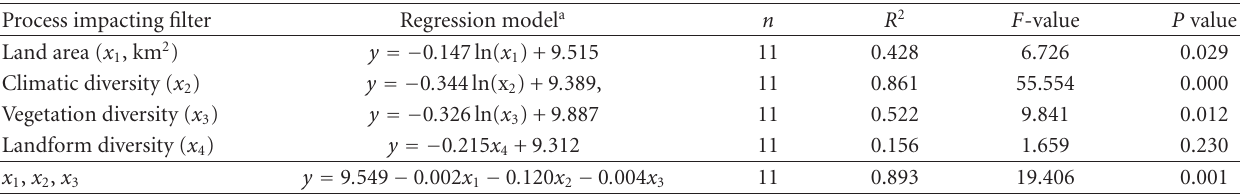
Table 4: The respective regression of species pool e ff ect, ln Y , from Yunnan flora region pool to flora subregion pools, on land area, climate, vegetation, and landform diversity in these subregion species pools, the multivariable regression, and